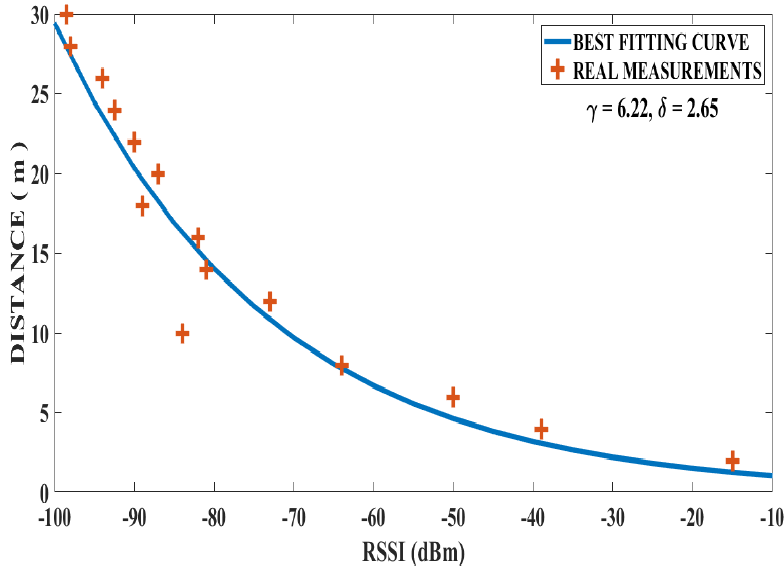
Figure 20. Pathloss exponent for device 2 deduced using best fitting